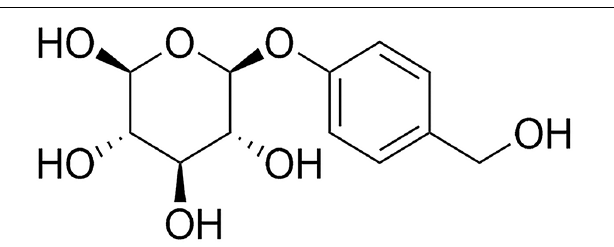
FIGURE 1 | Chemical structure of Gas; molecular weight is 286.3; molecular formula is C 13 H 18 O 7 .